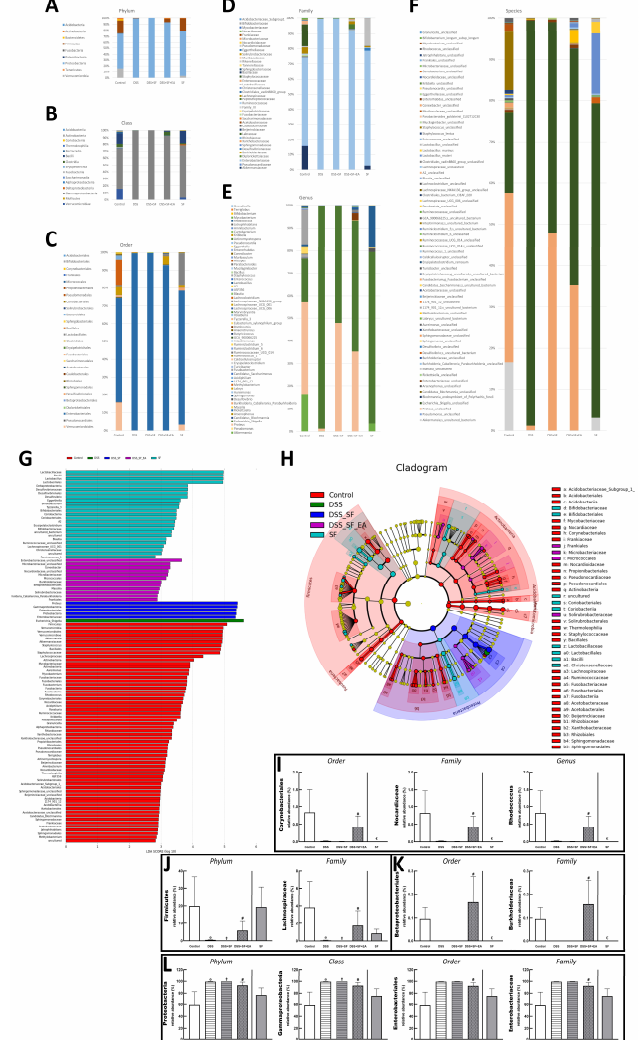
Figure 6. EA alters the intestinal microbial composition in DSS colitis mice with sleep fragmenta- tion. Microbial community bar plot by ( A ) phylum, ( B ) class, ( C ) order, ( D ) family, and ( E ) genus. ( G ) LEfSe (Linear discriminant analysis effect size). Comparisons of the relative abundance at the level of bacterial phylum. Each bar represents the effect size (LDA) for a particular taxa in a certain group. The length of the bar represents a log10 transformed LDA score. The colors represent which group that taxa was found to be more abundant compared to the other group. ( H ) LEfSe Cladogram. The green-group positive-enriched taxa are indicated with a positive LDA score (green) and red-group control-enriched taxa have a negative score (red). Only the taxa with meeting a significant LDA threshold value of >2 are shown. ( I – L ) Comparison of five groups in the specific microorganisms and their subordinates. ( I ) Comparison of five groups in the genus Rhodococcus and its superior (family and order) in bar charts. ( J ) Comparison of five groups in the family Lachnospiraceae and its superior (family and phylum) in bar charts. ( K ) Comparison of five groups in the family Burkholderiaceae and its superior (family and order) in bar charts. ( L ) Comparison of five groups in the family Enterobacte- riaceae and its superior (order, class, and phylum) in bar charts. Samples of the control group, DSS group, DSS + SF group, DSS + SF + EA group, and SF group were represented by groups (colored by each group name). (cid:64) , (cid:63) , #, and € represent the results of control group versus DSS group, DSS group versus DSS + SF group, DSS + SF group versus DSS + SF + EA group, and control group versus SF group, respectively. (cid:64) , (cid:63) , #, € , p < 0.05. (( A – L ), n = 4 in each group). DSS, dextran sodium sulfate; SF, sleep fragmentation; EA,